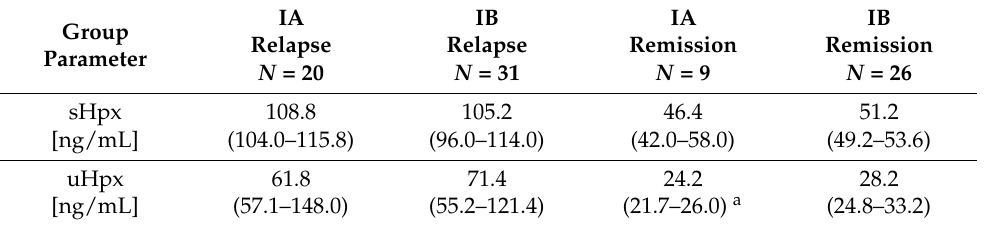
Table 3. sHpx and uHpx levels in INS subgroups according to the number of relapses (group IA—the onset of disease, IB—subsequent relapses). Data are presented as median values and interquartile ranges.